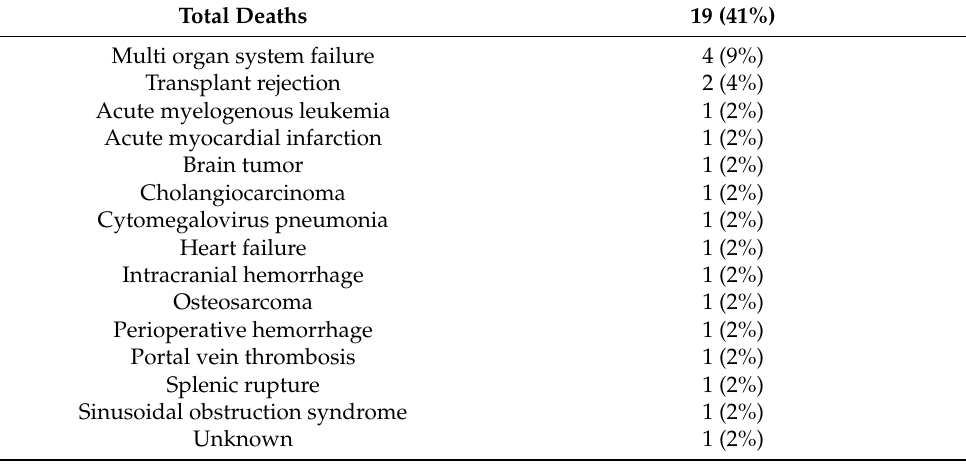
Table 4. Cause of death after liver transplantation for Budd-Chiari syndrome, n